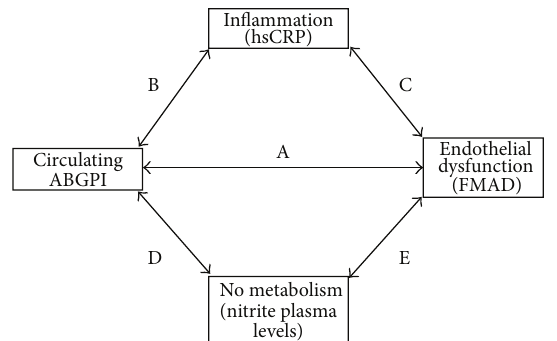
Figure 5: (A) Circulating anti-beta2-glycoprotein antibodies (ABGPI) titer was associated with flow-mediated arterial dilatation (FMAD) values ( 𝑃 = 0.01 ). (B) Circulating ABGPI titer was associated with C-reactive protein (hsCRP) levels ( 𝑃 = 0.04 ). (C) hsCRP levels were correlated with FMAD values ( 𝑃 < 0.01 ). (D) Circulating ABGPI titer was associated with nitrite plasma levels ( 𝑃 < 0.01 ). (E) We found a trend towards a correlation between nitrite plasma levels and FMAD ( 𝑃 = 0.07